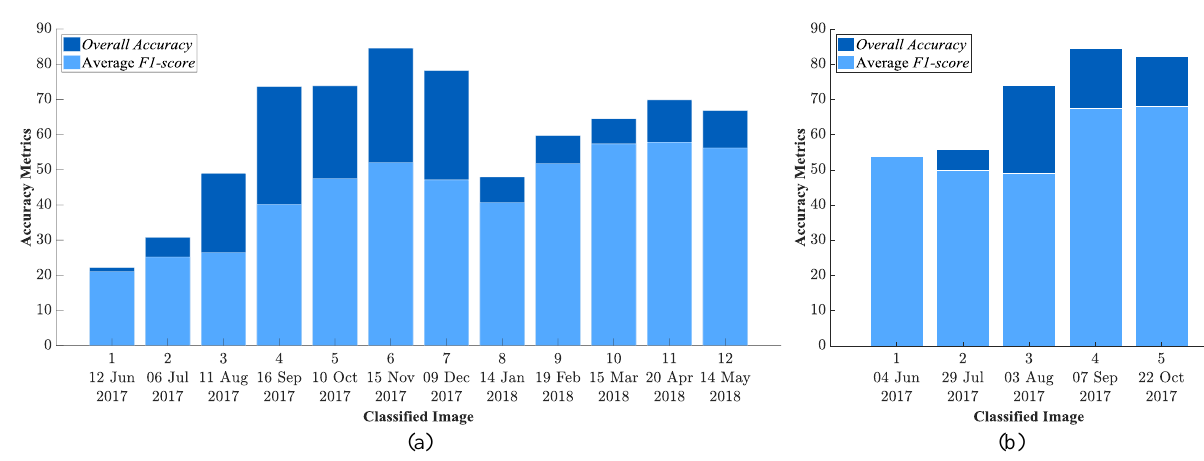
Figure 4. Overall accuracy (dark blue bars) and average F1-score (light blue bars) for different sequences (bar), formed by taking the first image and stacking more images to classify the last image in that sequence. Sequence of (a) C-band SAR Sentinel-1 images and (b) MSI/Sentinel-2 images